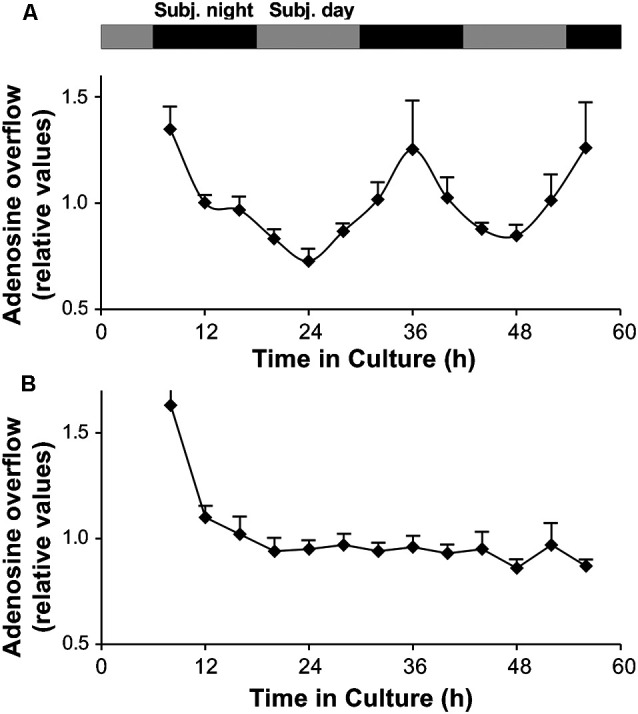
A circadian clock in the goldfish neural retina increases extracellular adenosine at night. (A,B) Long-term persistence of the circadian rhythm in adenosine overflow was observed from isolated intact neural retinas (A) but not from RPE-S (B) kept under constant conditions (see “Materials and Methods” section). Adenosine overflow was measured for more than 2 days at 4 h intervals when the culture medium was changed. The first data point was not included in the graph. Relative adenosine levels (amount of adenosine in each fraction divided by the average) are shown for better comparison between different retinas and between different RPE-S. Extracellular levels of adenosine were rhythmic (RM-ANOVA, F(12,48) = 5.852; P < 0.0001). COSINOR analysis of the rhythm revealed a period of 25.2 ± 1.6 h (p < 0.001, see “Materials and Methods” section for details). Data are from five retinas. (B) No circadian variations of adenosine overflow were observed from RPE-S under the same constant dark and temperature conditions (RM-ANOVA, F(12,36) = 0.767; P = 0.669). Data are from four RPE-S. (A,B) Gray and black bars indicate the subjective day and subjective night, respectively. Before stabilizing ~10 h following surgical isolation of tissue, adenosine overflow was relatively high, likely due to an acute effect of surgery. Data collected 4 h after surgery were therefore not included in the analysis of rhythmicity and are not shown.